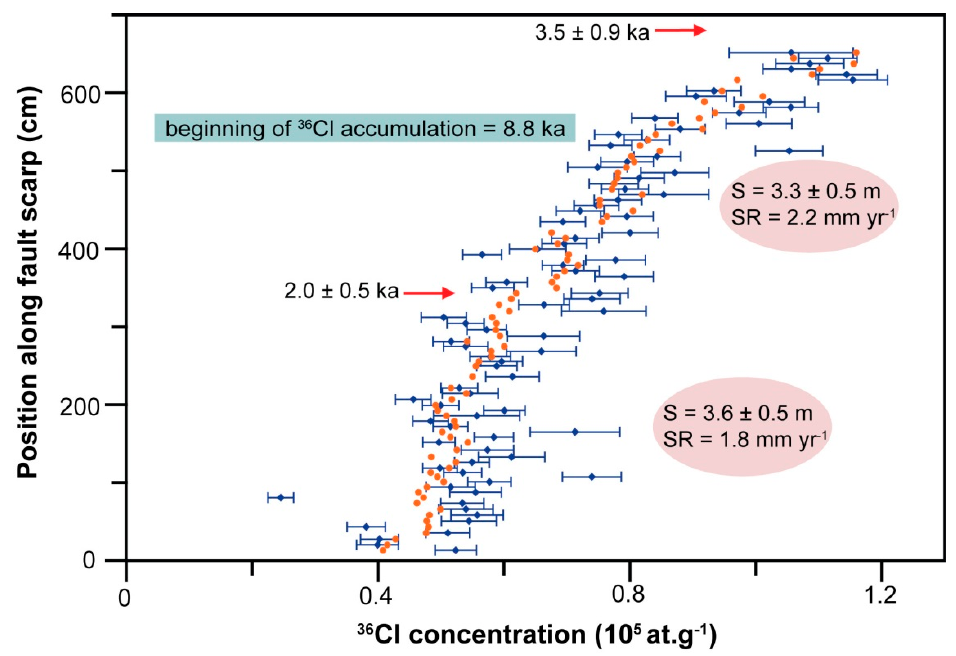
Figure 7. Best fit (filled circles) of the data for the samples from the Manast ı r fault scarp with a two seismic event model and beginning of 36 Cl accumulation ca. 8.8 ka. Dots with 2 σ uncertainties are measured 36 Cl concentrations. The arrows mark the colluvium positions before the modeled seismic event. S and SR define the amount of slip and incremental slip rate, respectively.